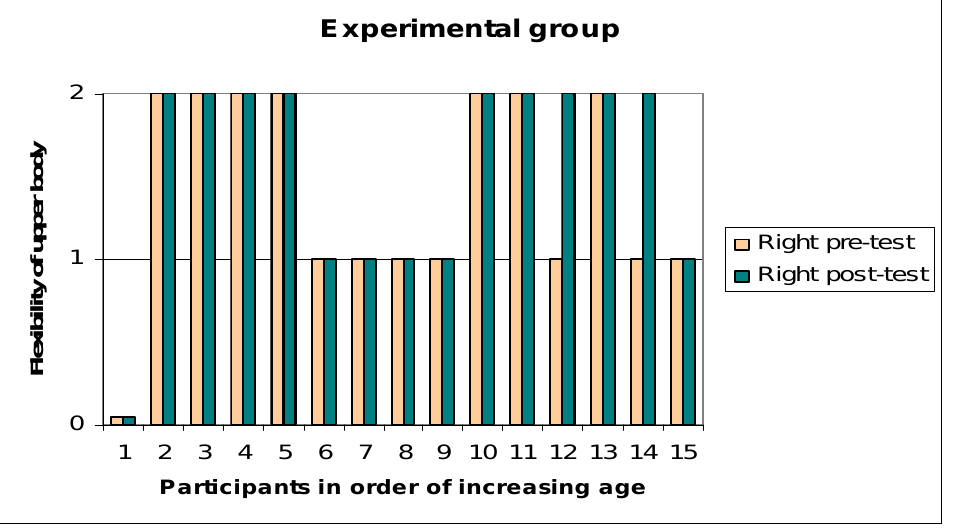
Figure 6 . For the classification of arm ROM, see legend to Figure 5.